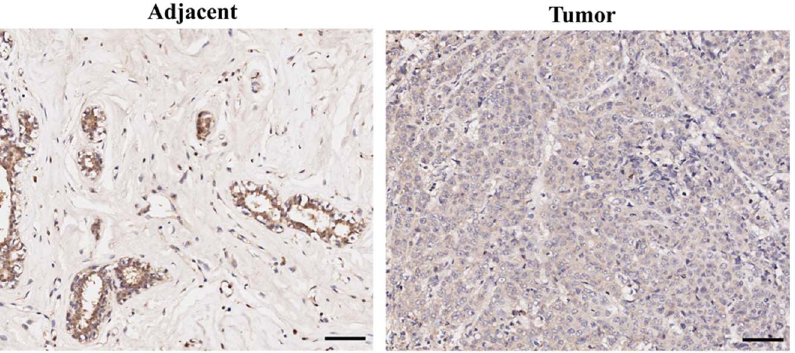
Figure 2. The representative protein expression of C10orf10 in pairs of BC and corresponding noncancerous breast tissues. Immunohistochemistry analysis of C10orf10 expression in 75 tumor and corresponding noncancerous samples, and C10orf10 is expressed in epithelial cells of corresponding noncancerous breast tissues (mainly expressed in the cytoplasm, and also mildly expressed in some part of the nucleus). C10orf10 expression is decreased in most BC tissues compared to corresponding noncancerous breast tissues. Immunohistological staining was performed with an anti-C10orf10 antibody, and scale bars are 100 m m.